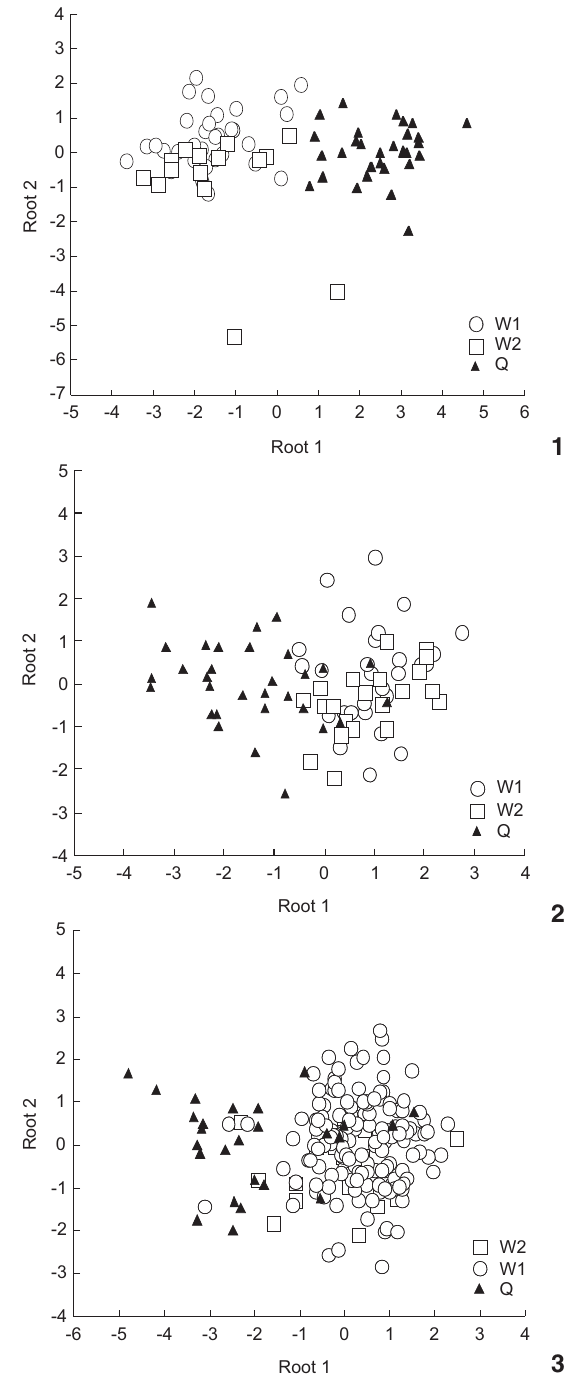
Figures 1-3. Female discrimination for colonies of P. compressa: (1) Colony 1; (2) Colony 2; (3) Colony 3. (Q) Queen, (W1) work- ers 1, (W2) workers 2. According to the Discriminant Function Analysis.